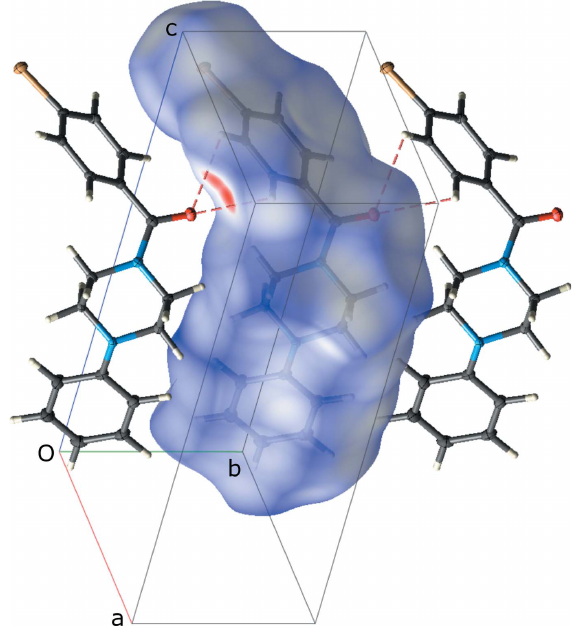
Figure 4 A partial packing plot of II , showing the Hirshfeld surface of the central molecule, highlighting (red blobs) the bifurcated close contacts (dashed lines) that join the molecules into chains parallel to the b -axis.